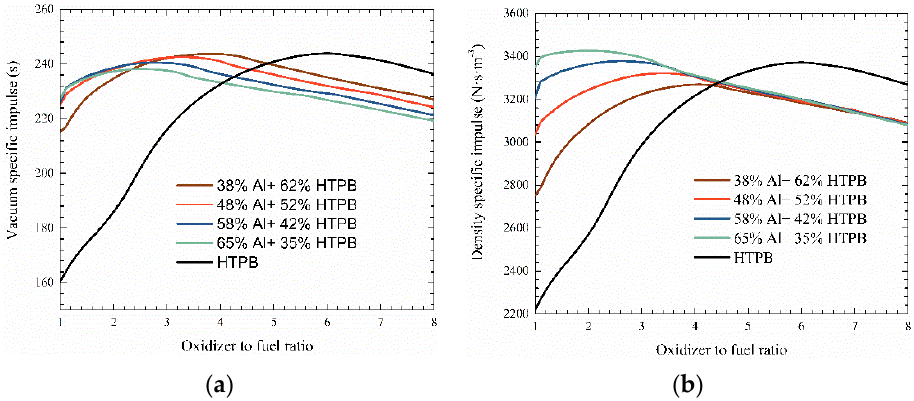
Figure 2. Theoretical vacuum specific impulse and theoretical vacuum density-specific impulse. ( a ) Theoretical vacuum specific impulse. ( b ) Theoretical vacuum density-specific impulse.